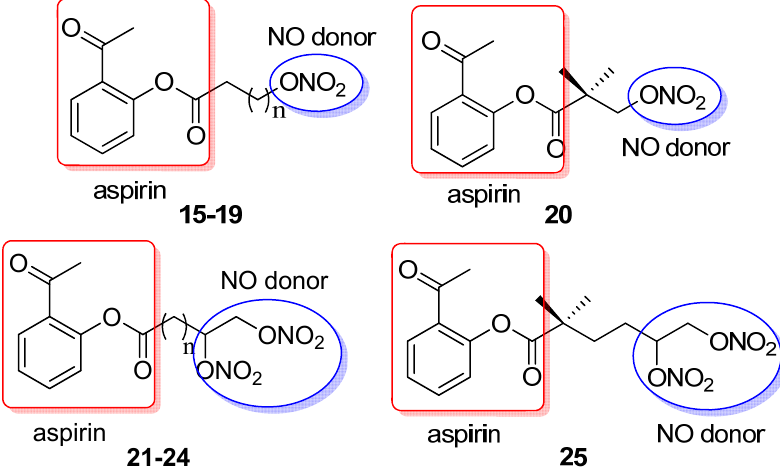
Figure 15. Hybrid aspirin/NO derivatives ( 15 n = 1; 16 n = 2; 17 n = 3; 18 n = 4; 19 n =